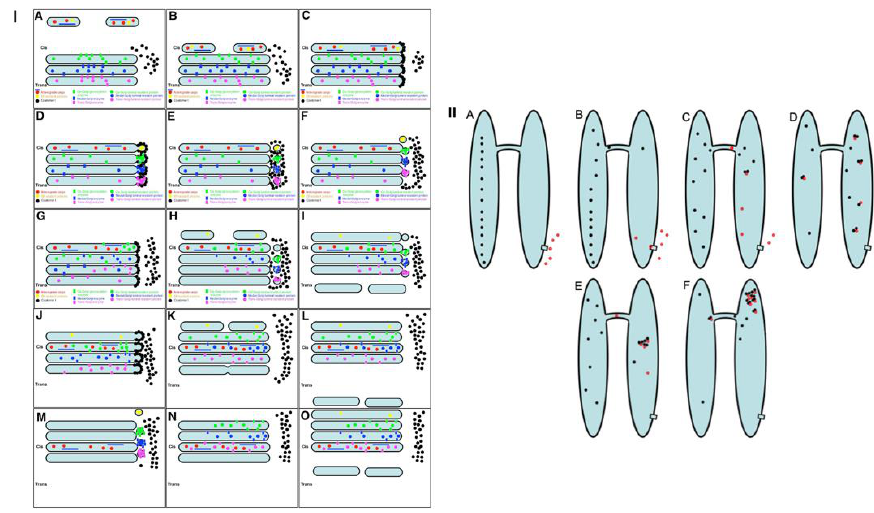
Figure 1. Schemes of intra-Golgi transport (IGT). (( I ): ( A – O )) Mechanisms of IGT according to the cisterna maturation–progression model of intracellular Golgi transport (CMPM; see Movie S1). ( A ) Two ER-Golgi carriers (EGCs) are shown in the upper part of the Figure. They contain mega-cargo (blue lines) and soluble secreftory cargo (red dots). ( B ) These carriers arrive on the opposite side of the Golgi complex. ( C ) The EGCs fuse and form a new cis-cisterna that contains these mega- and soluble cargoes. Coatomer I (black dots) forms coats on cisternal rims. ( D ) Formation of COPI-coated buds on rims of all of the Golgi cisternae. These buds are enriched in Golgi glycosylation enzymes corresponding to the positions of the cisternae on which they are formed. ( E ) Division of the copy- covered kidneys. During division, these buds turn into ‘bubbles’ enriched with Golgi enzymes and then undergo coat removal. ( F ) Fusion of COPI-dependent vesicles with proximal cisterna. Recycling of Golgi enzymes into the corresponding proximal cisterna. ( G ) Attachment of COPI to the rims of the cisternae. ( H ) Arrival of new ER-Golgi carriers and formation of a new cis-cisterna, as well as fission of the neck of COPI-coated buds and division of bubbles, and formation of an empty trans-cisterna. ( I ) Merging of carriers to form a new cis- cisterna. Fusion of COPI-dependent vesicles with proximal cisternae and formation of two carriers after the Golgi from an empty trans-cisterna. ( J – O ) Two consecutive rounds of the same process that occurs distally along the Golgi stack. As a result, the cis- cisterna containing the mega-cargo (blue lines) and soluble cargo (red dots) appears on the trans-position within the stack. (( II ): ( A – F )) Mechanisms of concentration of soluble cargoes according to the symmetric KARM (the carrier maturation model). Black dots, soluble cargo; red dots, proton pumping inside the distal compartment. The soluble cargo can diffuse in both directions through a thin tube connecting the two compartments. In the bottom part of the distal compartment, there is a proton pump (( A ); square), which moves protons into the lumen of the distal compartment ( B ). When a proton attaches to the cargo, the cargo molecule tends to form aggregates ( C , D ). Aggregates become larger than the original molecule and cannot move through the tubes in